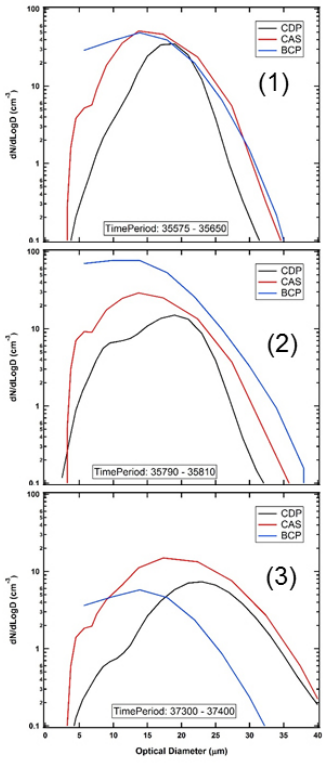
Figure 12. The size distributions shown here illustrate how the backscatter cloud probe (BCP) compares with the cloud droplet probe (CDP) and cloud and aerosol spectrometer (CAS). The spec- tra were averaged over the three time periods marked with boxes in Fig. 10b when the aircraft was in a liquid-water cloud. The BCP has 10 channels (blue), whereas the CDP (black) and CAS (red) have 30